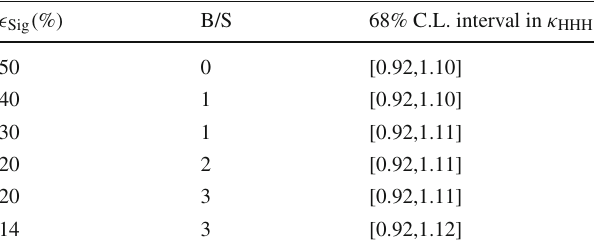
Table 9 Constraints on κ HHH obtained in the full detector simulation study using a multivariate analysis for selection. The constraint from crosssectiononlyisobtainedinthetightBDTselection.Theconstraints basedondifferentialdistributionsarederivedinthelooseBDTselection Constraints for κ HHH based